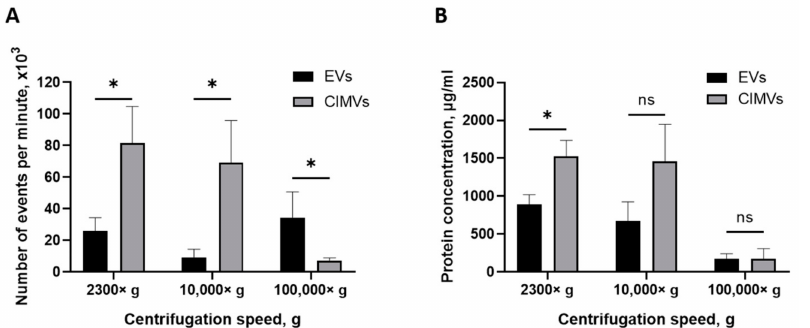
Figure 4. Analysis of EVs and CIMVs yield. ( A ) Average number of EVs and CIMV after centrifuga- tion 2300 × g , 10,000 × g , and 100,000 × g . Flow cytometry method. ( B ) Total protein concentrations of EVs and CIMVs after centrifugation 2300 × g , 10,000 × g , and 100,000 × g . Bicinchoninic acid method. The data represent mean ± SD. ns—not statistically significant. (*)—level of significance p < 0.05. One of the most popular methods for expressing the amount of EVs is the total protein concentration [39]. Therefore, we also evaluated the yield of vesicles by determining the total protein concentration. We found that the average yields of EVs and CIMVs obtained after centrifugation at 2300 × g were 888.12 ± 131 µ g/mL and 1525.59 ± 210 µ g/mL in total protein concentration, respectively ( p = 0.02), at 10,000 × g were 673.27 ± 254 µ g/mL and 1455.94 ± 493 µ g/mL, respectively ( p = 0.09), and at 100,000 × g were 175.10 ±